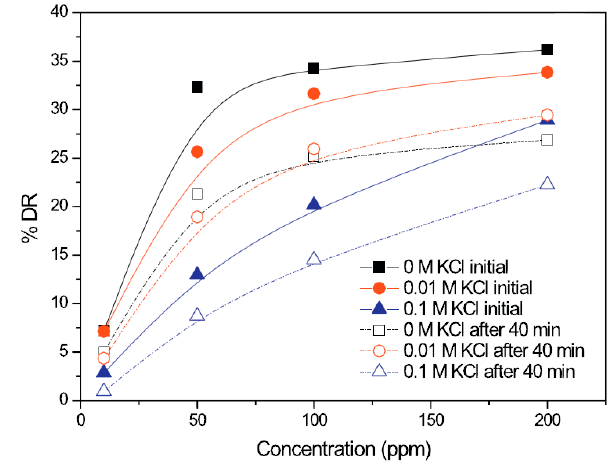
Figure 3. Concentration dependence of % DR with xanthan gum (XG), reprinted with permission from [65]. Copyright Elsevier Ltd.,